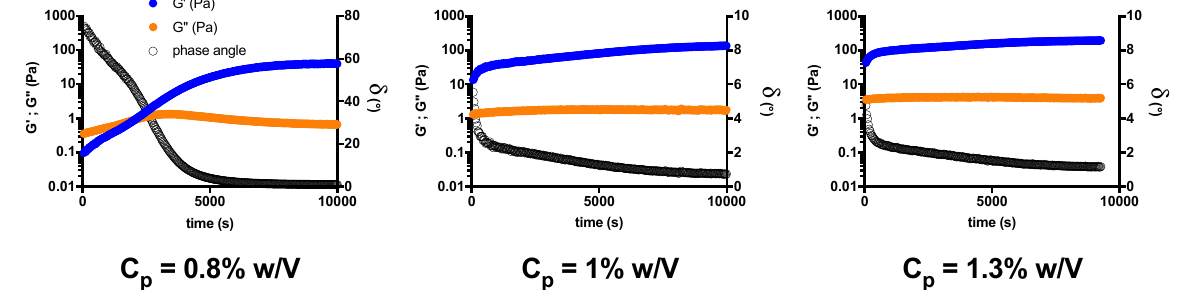
Figure 1. Gelling kinetics of highly acetylated chitosan sample (ACh1). Dependence of storage modulus ( G ′ , in blue), viscous modulus ( G ″ , in orange) and phase angle (empty circles) as a function of time. Final experimental conditions: (ACh1) = 0.8–1.3% w/V, (genipin) = 0.31 mM, gelling temperature 60 ◦ C, 1 × PBS as solvent, pH